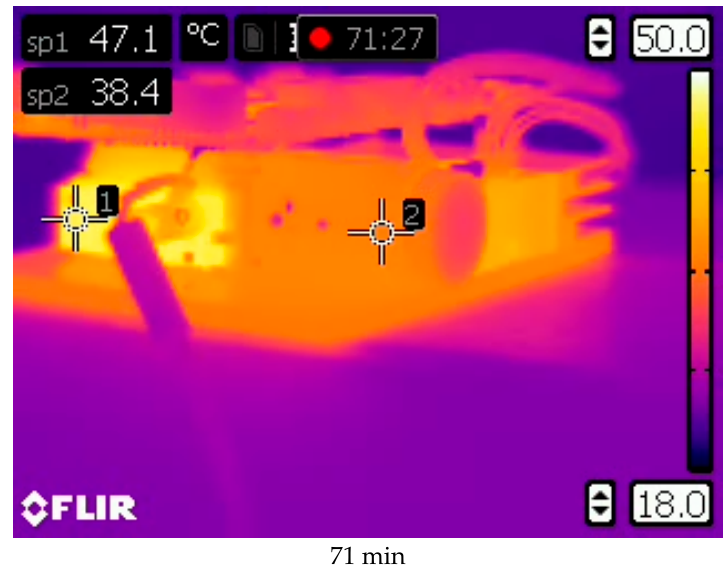
Figure 3. The warming-up process of the DLP LightCrafter 4500 projector, registered with thermal camera Flir E40. The colors on the presented images show the projector temperature in the first 71 min after turning on the power supply. The LED source is the warmer place on the projector (measuring point sp1).